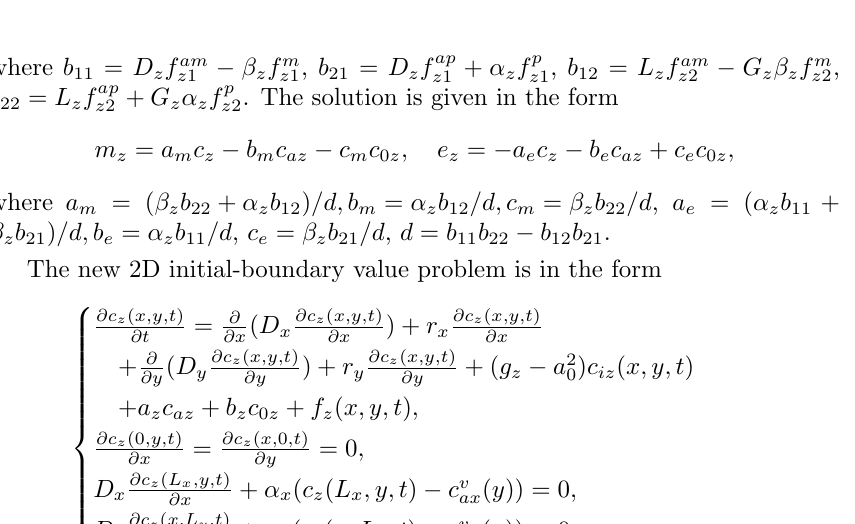
Figure 6. Values of functions f 1 z 1 for exponential spline, a 1 1 z ∈ [ −